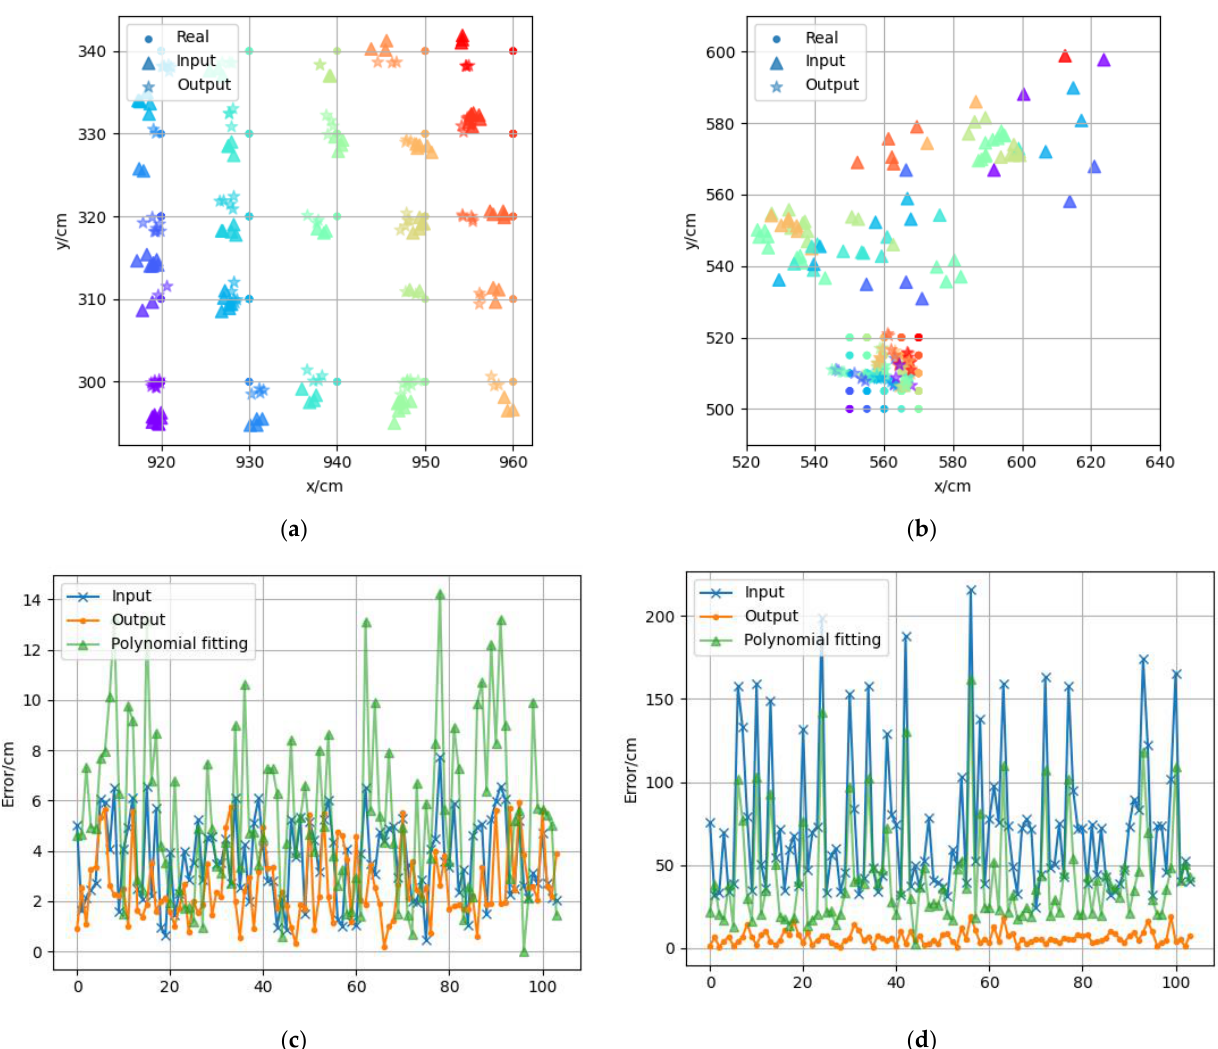
Figure 11. Results of Positioning Error Mitigation in LOS ( a ) and NLOS ( b ). Comparison of Error Mitigation Results for Neural Networks and Polynomial Fitting in LOS ( c ) and NLOS ( d ).